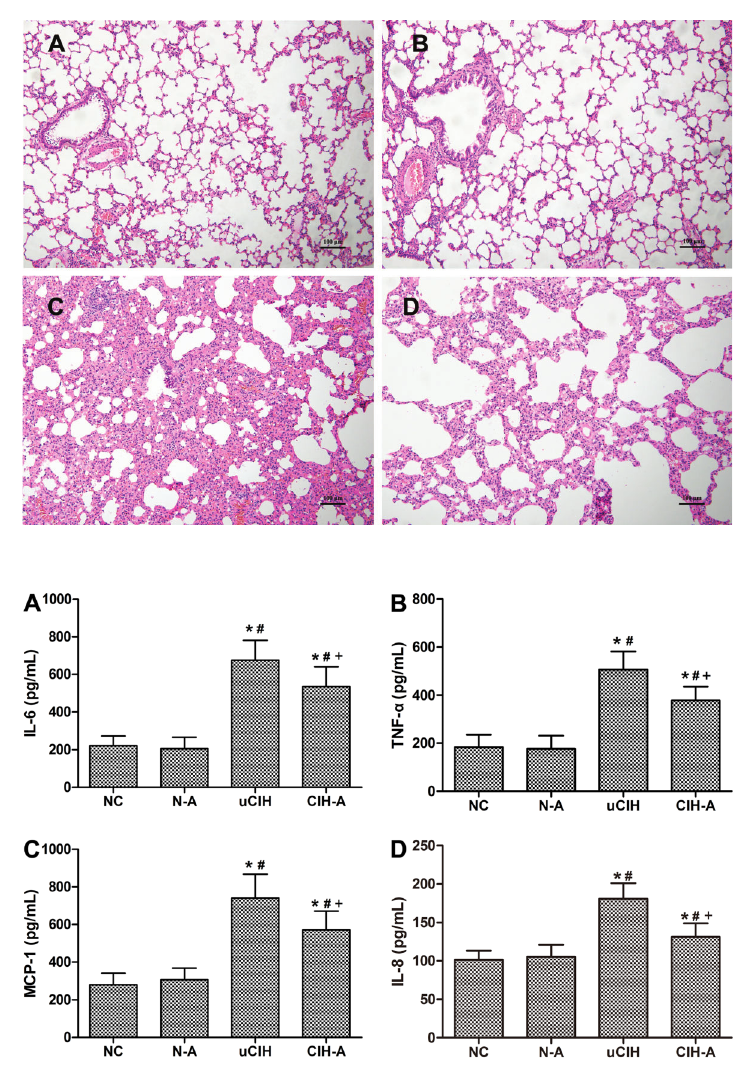
Immunohistochemical analysis showed a signi fi cant increase in TNF- a , IL-6, and IL-8 expression in the lung tissues of the uCIH group compared to that in the CIH-A group (uCIH vs CIH-A: TNF- a : 25,979.23 ± 907.38 vs 13,827.20 ± 712.59; IL-6: 19,979.23 ± 811.61 vs 11,827.20 ± 703.88; IL-8: 7,958.01 ± 771.15 vs 5,810.09 ± 604.93, all P o 0.05). No statistical difference in the expression of these cytokines was observed between the NC and N-A groups (P 4 0.05; Figure 3).